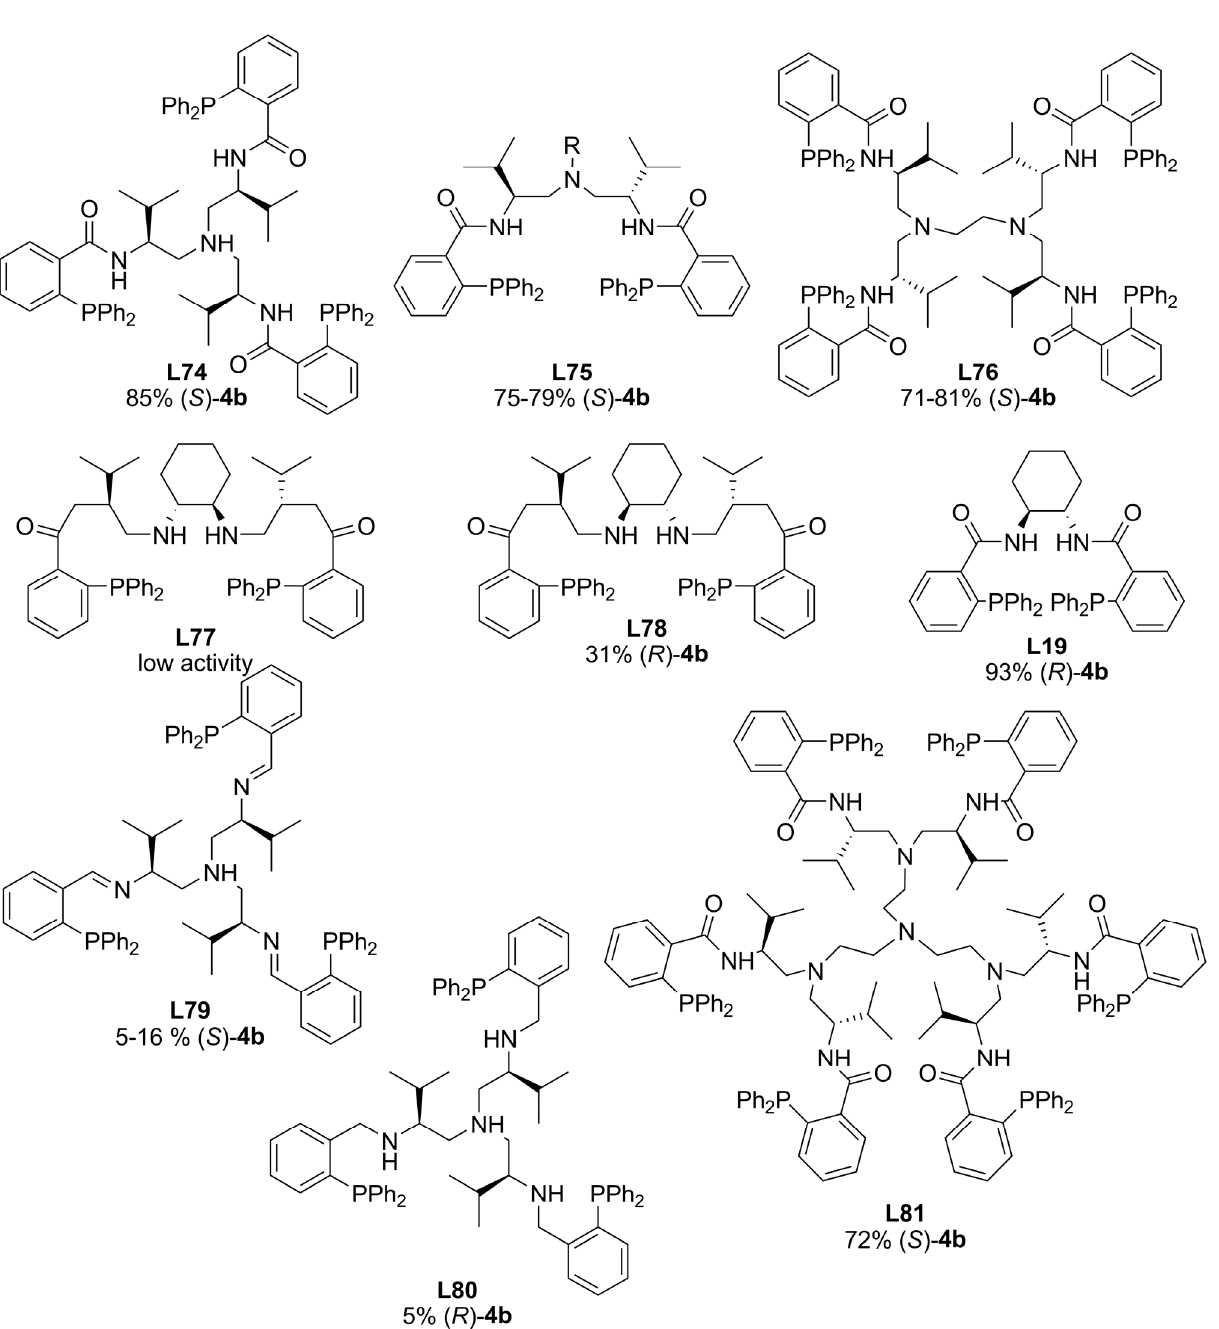
Figure 28. Multidentate